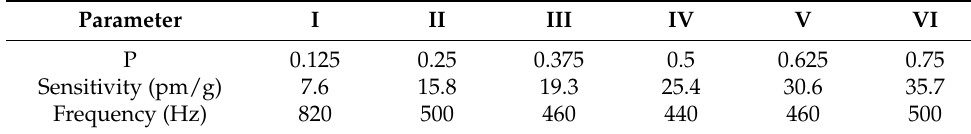
Table 1. Performance of the six